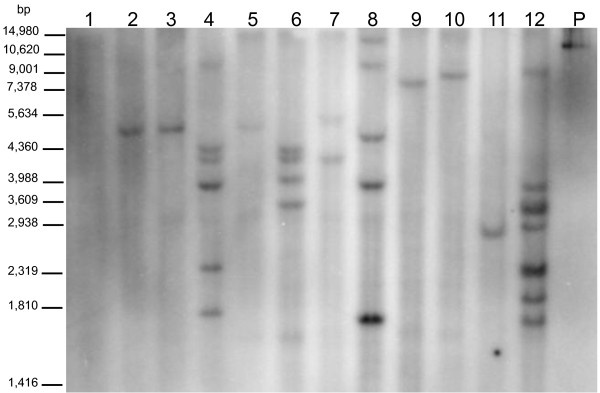
Southern blot analyses of transgenic coffee plants. Coffee DNA from leaf material was digested with EcoRI, electrophoresed and probed with a 32P labeled HPTII gene fragment. The number of bands reflects the number of transgene insertion sites. Lane 1, untransformed coffee (control). Lanes 2-12, transgenic plants from independent transformation events. P - plasmid control (pMDC32). The size of the markers is indicated on the left.